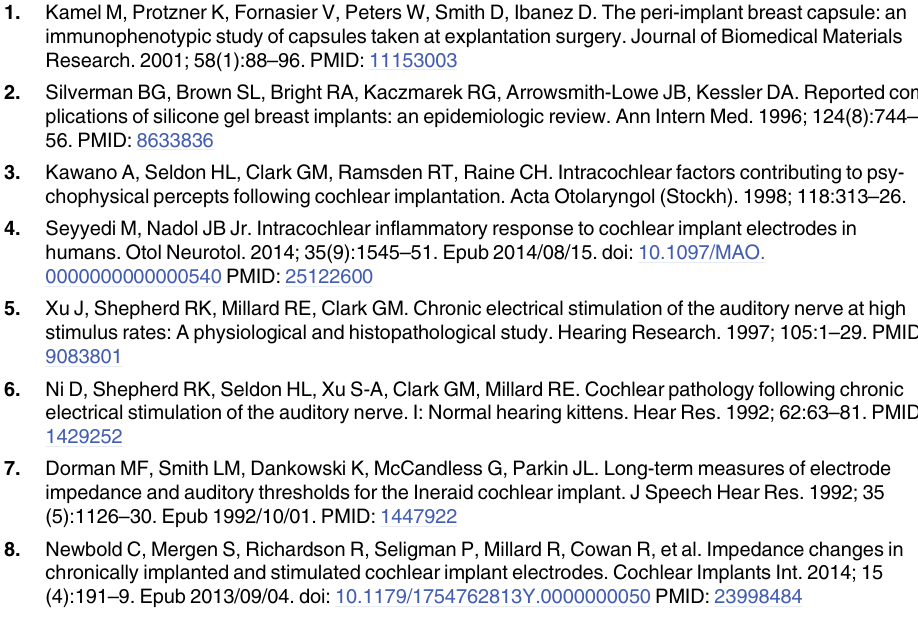
S1 Fig. Effect of short term electrical stimulation on fibrosis. No effect of 60 minutes electri- cal stimulation per week was detected on connective tissue growth along the whole area ana- lysed (left graph). In the region of the round window niche (RWN, right graph) electrical stimulation seems to have increased the tissue response (bar 0%DEX), leading to more connec- tive tissue growth around the implant in that area. (cid:1) = p < 0.05; (cid:1)(cid:1) = p < 0.01; ns = not signifi- cant; error bars =